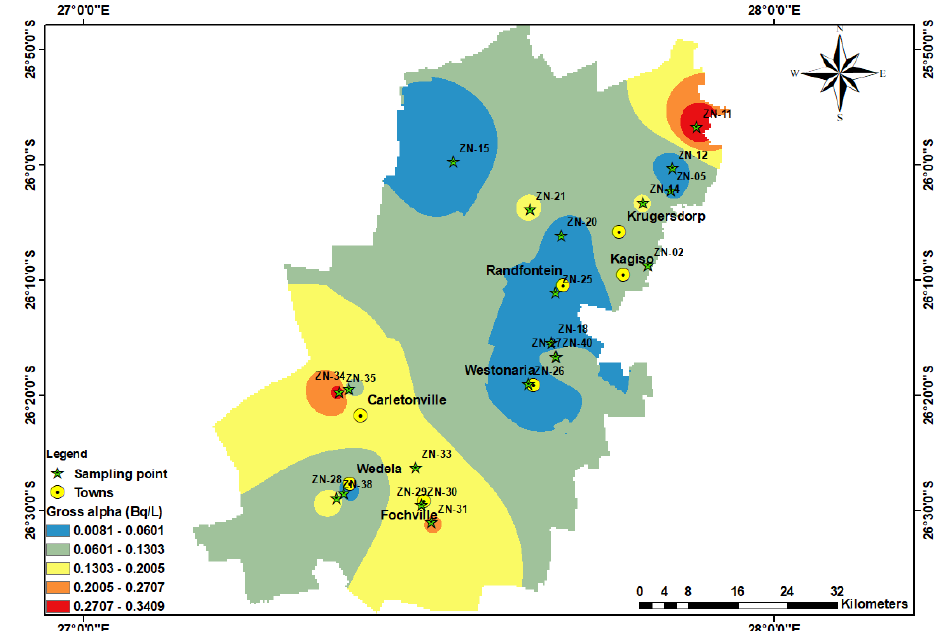
Figure 5. Spatial distribution map of gross alpha activity in the West Rand region. 3.2. Tritium